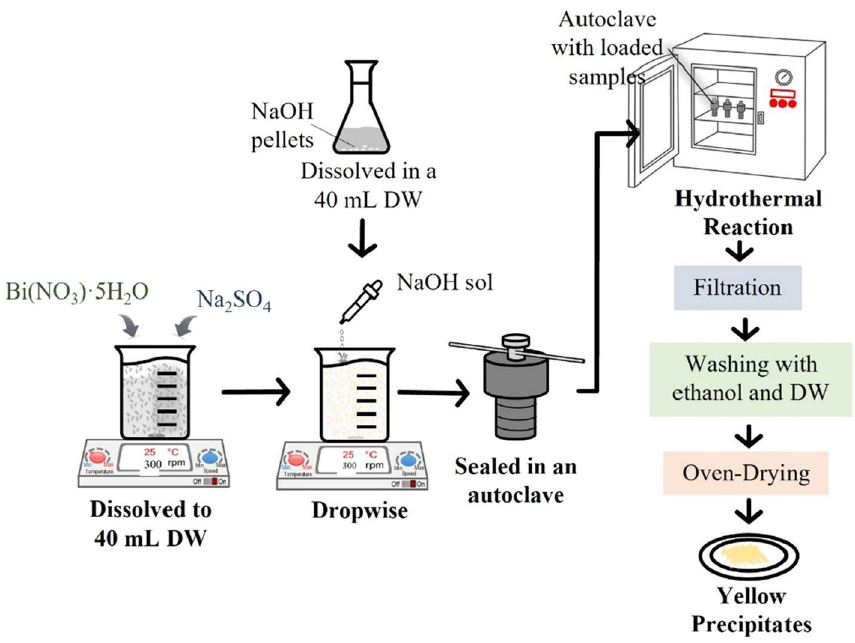
Figure 2. Flow chart of the hydrothermal synthesis of Bi 2 O 3